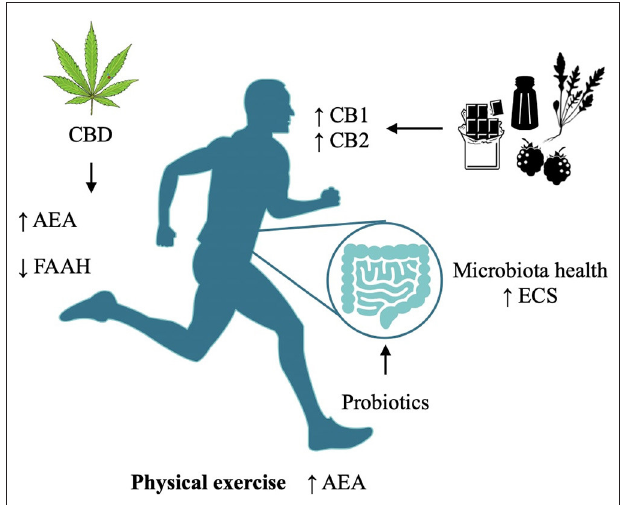
FIGURE 2 | Modulation of the Endocannabinoid System via different methodologies and their